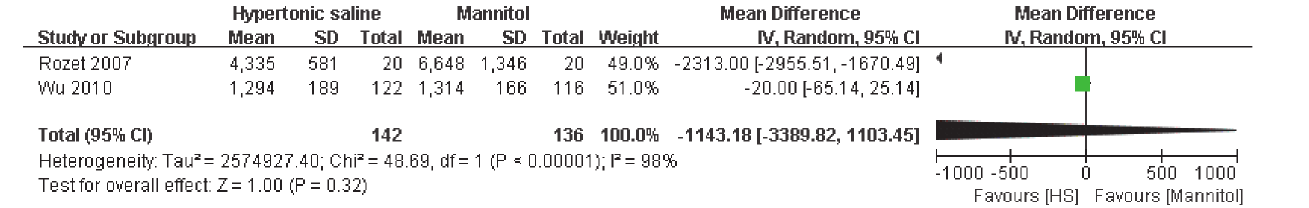
Fig 4. Total volume of intravenous fluid required during neurosurgery in HS and mannitol groups. IV: Inverse Variance.